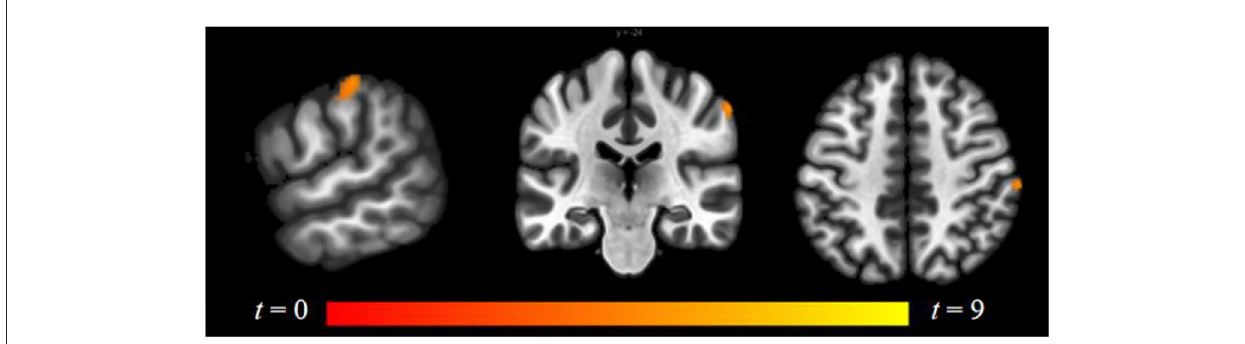
FIGURE4 Within-group differences between menses phase and follicular phase. The hot color scale indicates higher left amygdala–right supramarginal gyrus resting-state functional connectivity (RSFC) in the menses phase than follicular phase. Coordinates are given in MNI space and statistics in t -values.